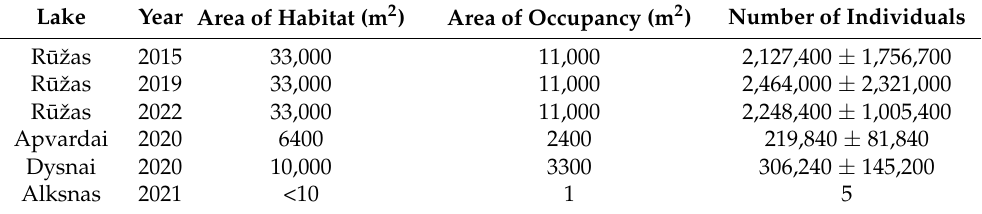
Table 2. Area of Aldrovanda vesiculosa habitats, area of occurrence, and calculated number of individ- uals (mean ± SD) in the studied lakes. Lake Year Area of Habitat (m 2 ) Area of Occupancy (m 2